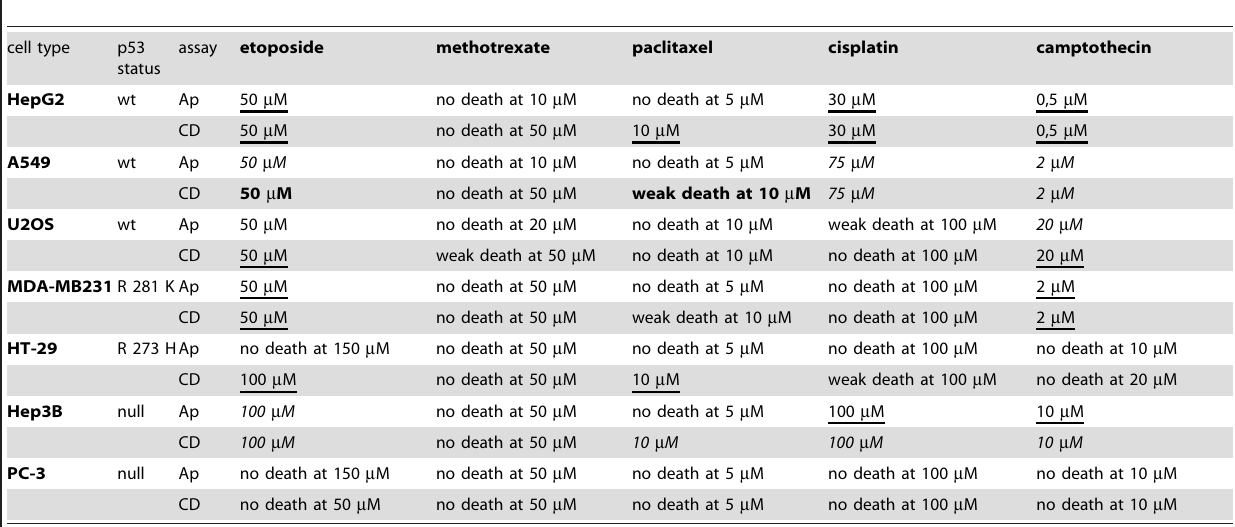
Table 1. Effect of hypoxia on chemotherapeutic agents-induced cell death.